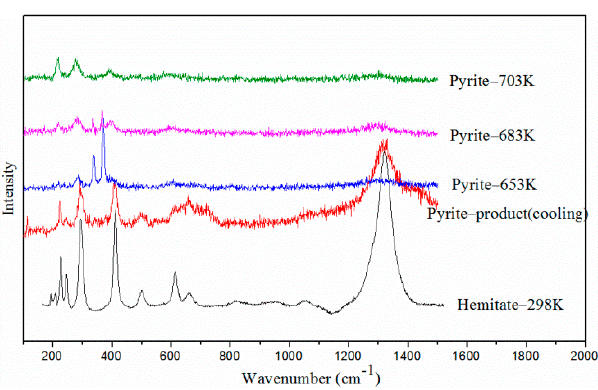
Figure 3. Wavenumber of six peak variations with increasing temperature.